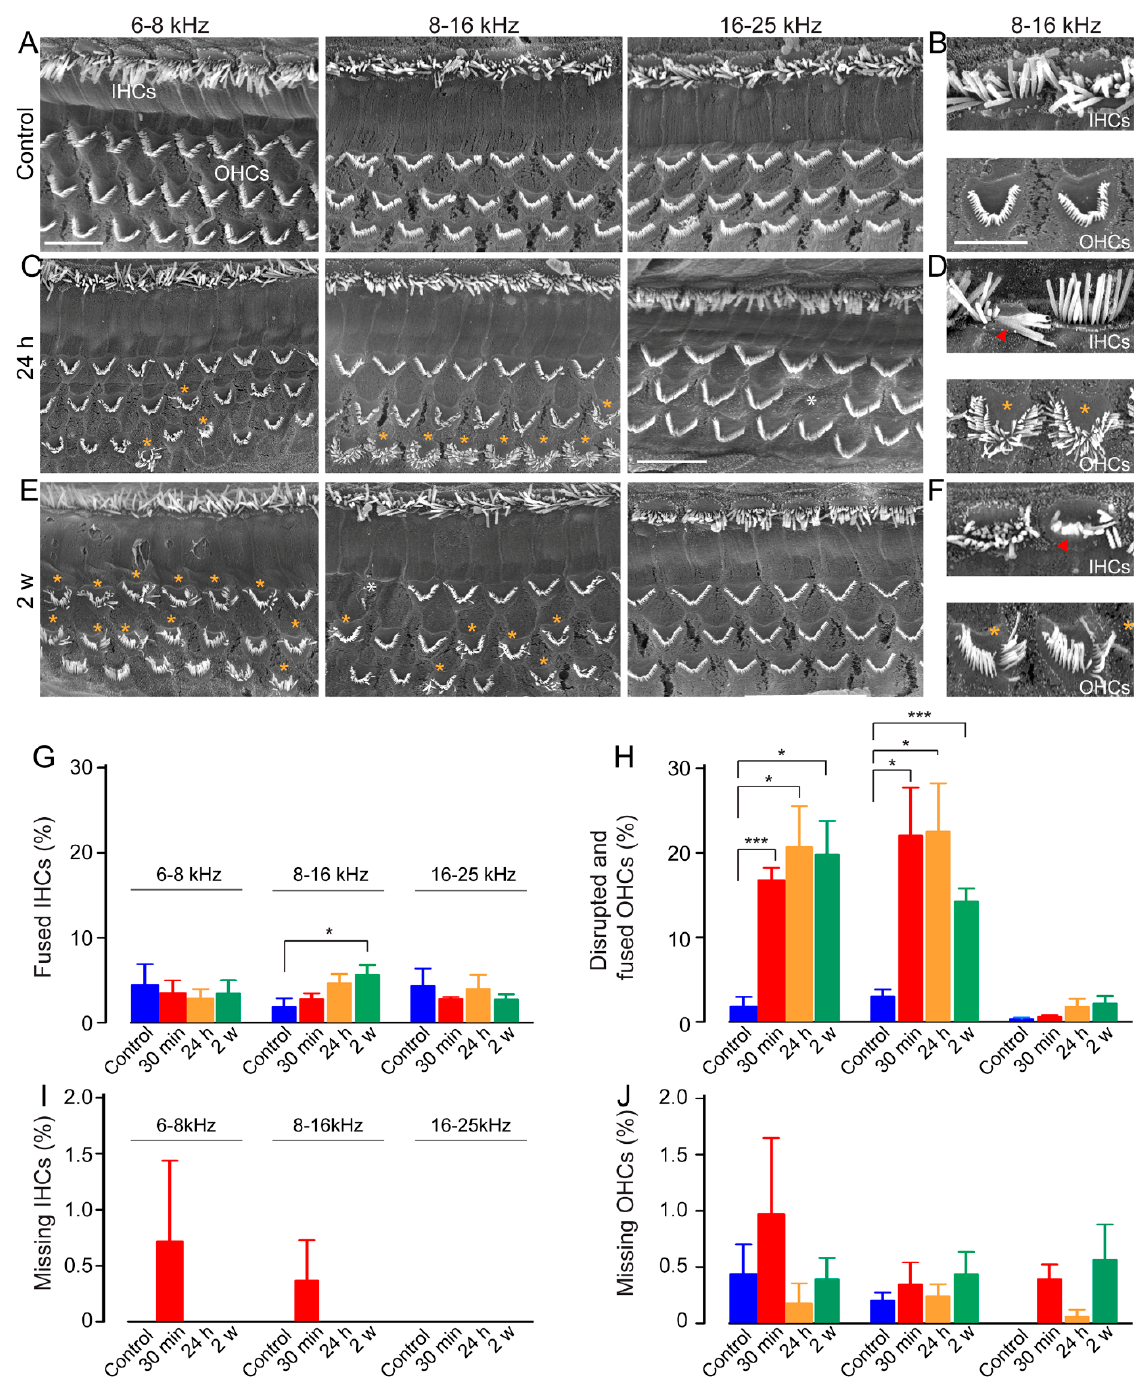
Figure 4. Alteration of the OHC stereocilia A, C and E: Representative scanning electron microscopy from different coding regions of cochleae (6–8 kHz, 8–16 kHz, 16–25 kHz) from control ( A ), 24 h ( C ), and 2 weeks ( E ) after exposure. ( B , D , F ): Higher-magnification images of representative hair bundles of the OHCs located in the region coding 8–16 kHz. Yellow and white asterisks indicate disrupted and fragmented hair bundles of the OHCs and loss of OHC, respectively. Red asterisks pinpoint fused stereocilia of the IHCs. Scale bars: 15 µm. ( G – J ): Cytocochleograms representing the percentage of fused IHCs ( G ) disrupted and fused OHCs ( H ), missing IHCs ( I ), and missing OHCs ( J ) in different coding regions (6–8, 8–16, 16–25 kHz) from control (blue bars), 30 min (red bars), 24 h (orange bars) and 2 weeks (green bars) after exposure. Data are expressed as mean ± SEM ( n = 6 to 12 cochleae per age and genotype). One-way ANOVA test was followed by Dunn’s test. * p ≤ 0.05, *** p ≤ 0.001, vs . control.